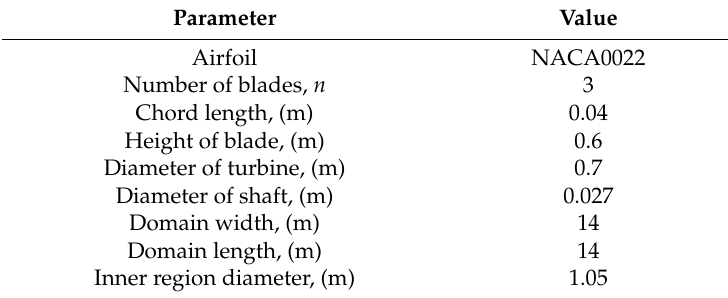
Table 1. Geometrical characteristics of vertical axis wind turbines (VAWT) and computational